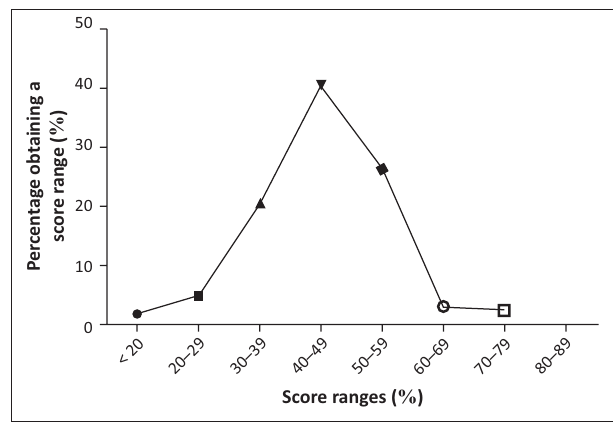
FIGURE 1: Frequency of distribution of the knowledge scores of the